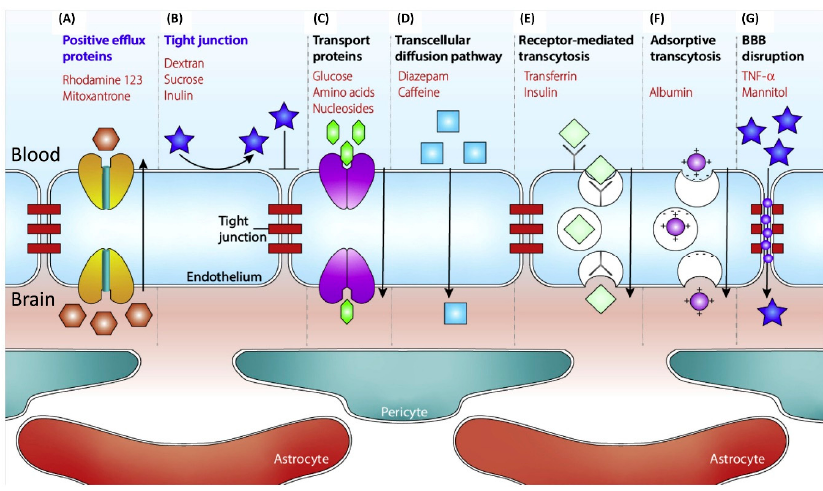
Figure 3. BBB transport pathways. A schematic diagram of endothelial cells (ECs), pericytes, and astrocytes forming the BBB. ( A ) The activity of e ffl ux transport proteins such as p-glycoprotein (P-gp). ( B ) Selective permeability of tight BBB. ( C ) Carrier mediated pathway. ( D ) Passive transportation. ( E ) Receptor mediated pathway. ( F ) Adsorptive mediated pathway. ( G ) Natural occurring biomolecules increase the permeability of the brain endothelium. Reproduced from “Advanced in Microfluidic Blood-Brain Barrier (BBB) Models”, with permission from Elsevier,